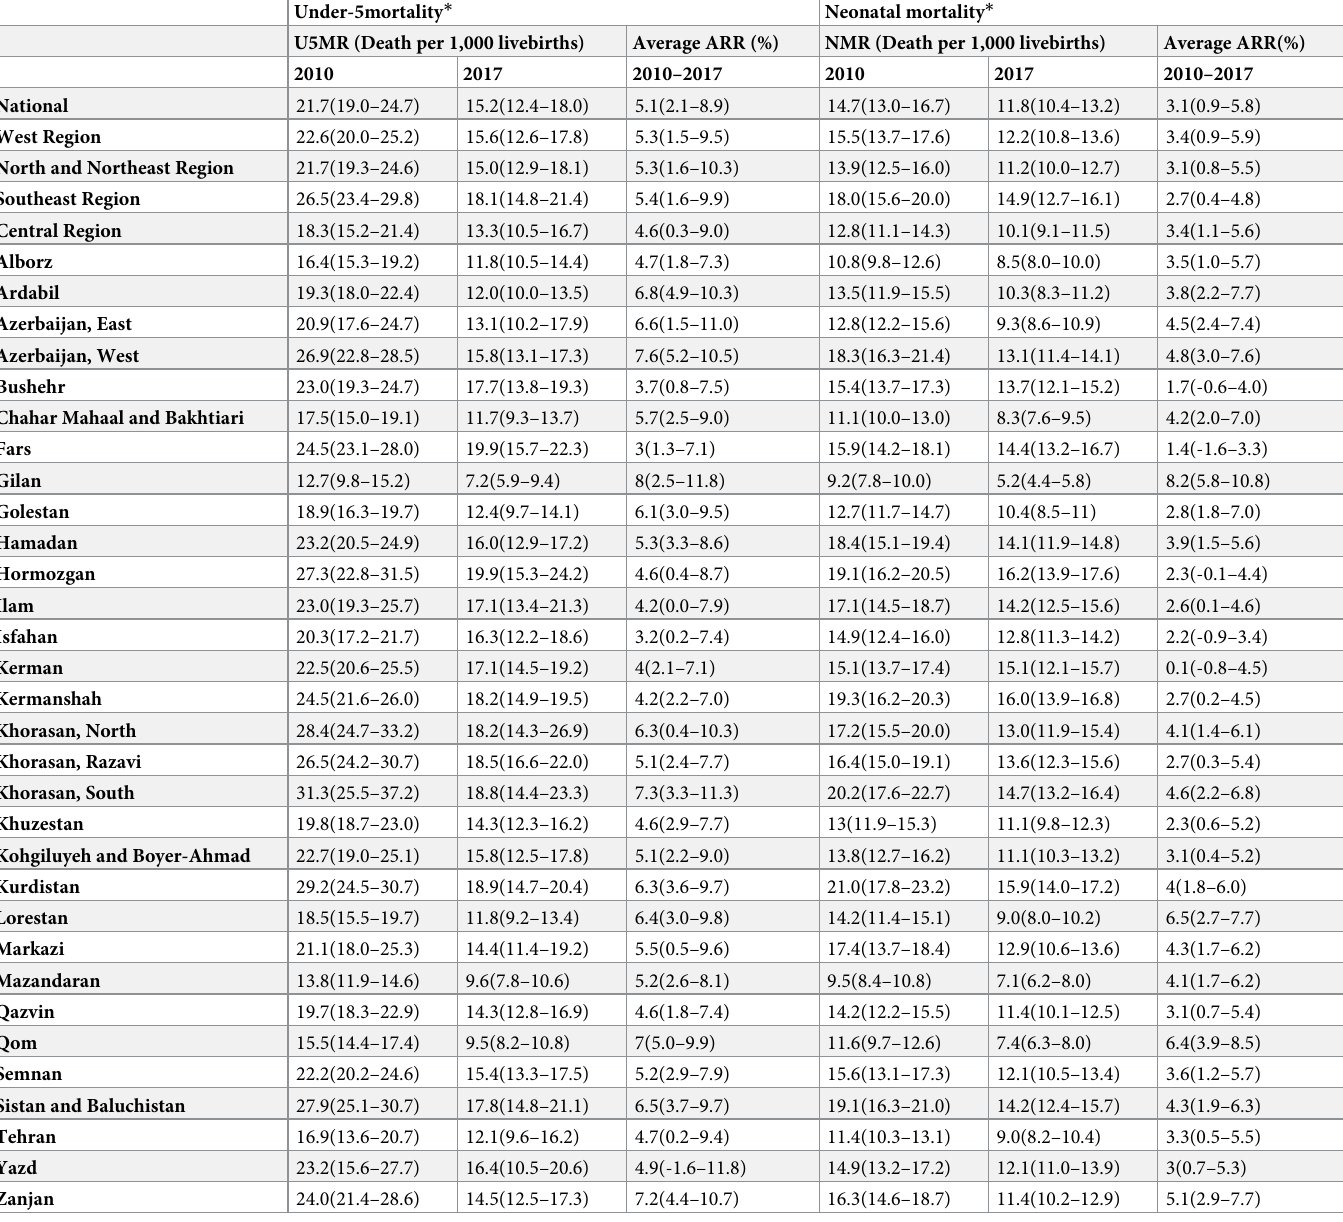
Table 1. National, regional, and provincial U5MRs and NMRs in 2010 and 2017, with AARRs during